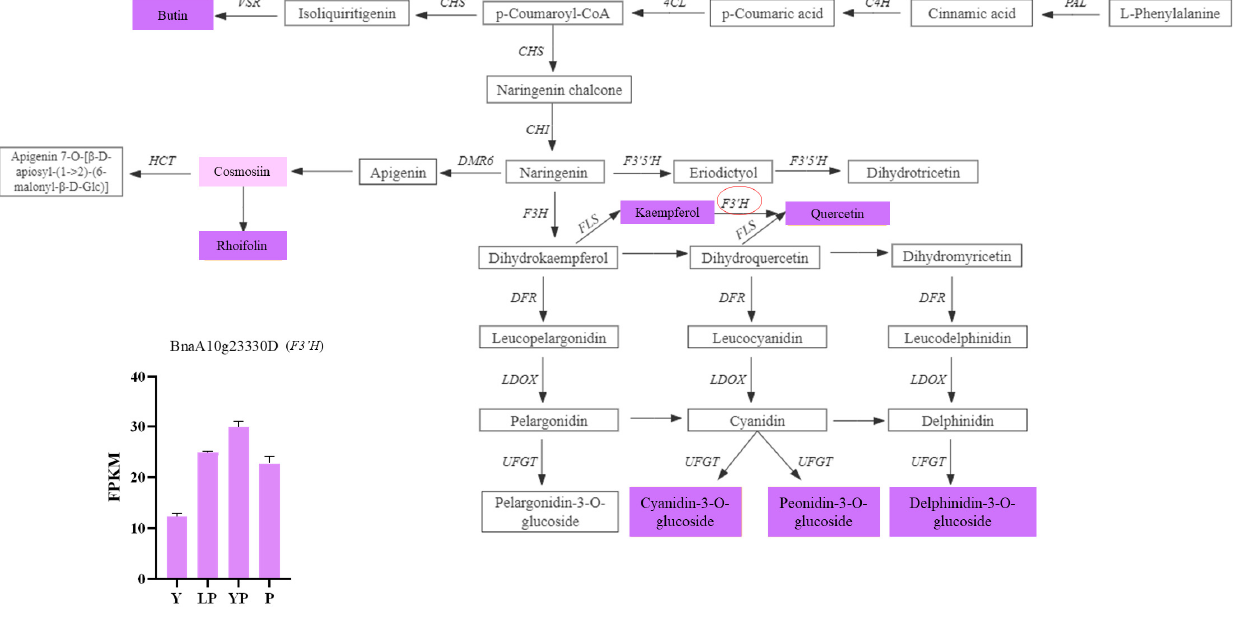
Figure 10. The flavonoid biosynthetic pathway. Heat maps of the DEGs between LP, YP, P, and Y. The light purple and purple boxes indicate significantly upregulated/downregulated metabolites in the flavonoid metabolic pathway. The F3’H gene ( BnaA10g23330D ) circled in red is the key differential gene in the flavonoid pathway that regulates purple flower